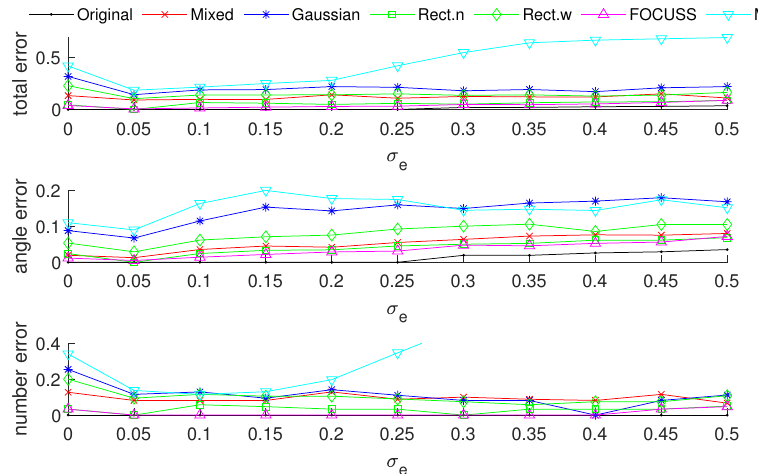
Figure 3. Direction-of-arrival (DOA) estimation error in the optimal subpattern alignment (OSPA) distance via different arrays based on different weights and uniform linear arrays (ULAs) when K = 20; the prior information of DOA is reliable and σ p = 30.